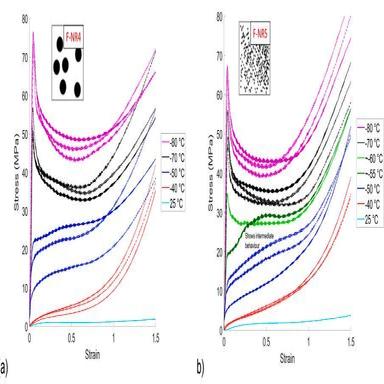
Low rate, varying temperature results for the 50% filled composites: (a) F-NR4 and (b) F-NR5.